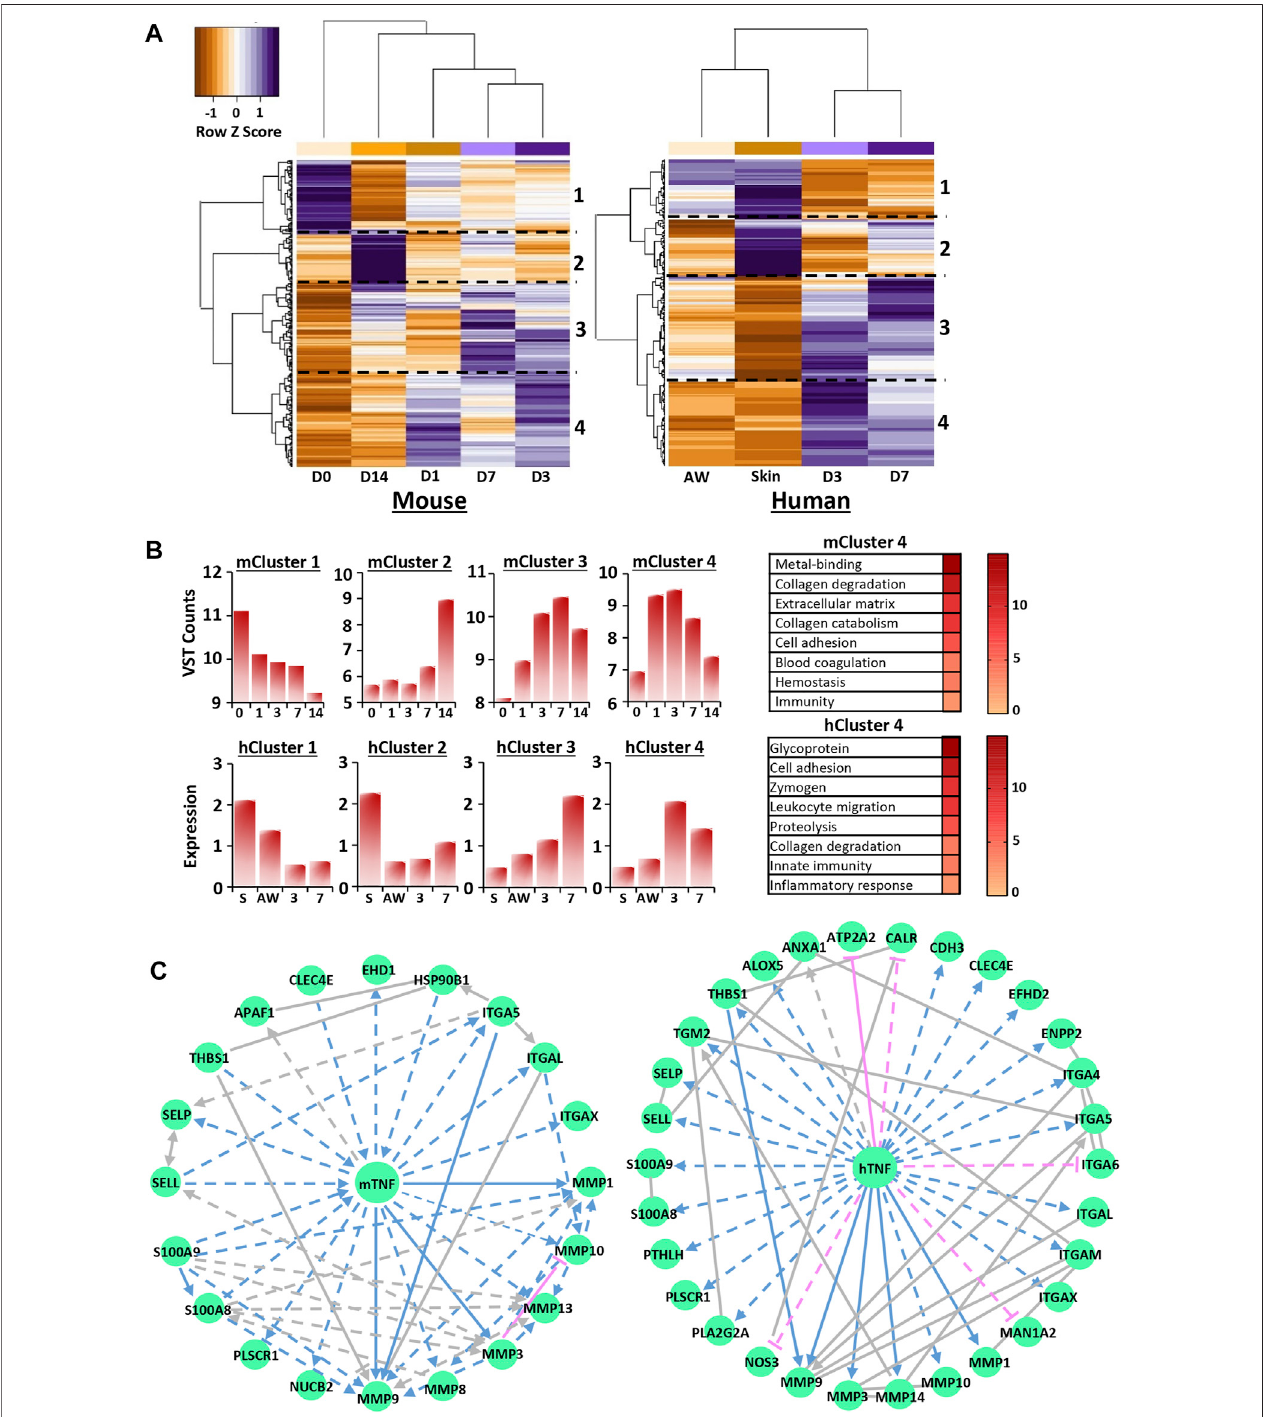
FIGURE 5 | Transcriptional regulation of calcium is wound stage speci fi c and converges on key upstream regulators. Hierarchal clustering of the top 250 most signi fi cantgenesinmouseRNA-Seqandhumanmicroarray fi lteredfromthecalciumUniProtknowledgebase(KB)listforeachspecies[KW-0106; (A) ].D0 (cid:2) normalskin. D1 (cid:2) day 1post-wounding.Cut-off (cid:2) Benjamini-Hochbergadjusted p value( P adjust) < 0.05andlog 2 foldchange (cid:2) 0.58. Functionalannotationofidenti fi edclustersand theirexpressionpro fi les (B) .VST (cid:2) variancestabilisedtransformation.NetworkanalysisidentifyingTNFasatoptranscriptionalregulatorforcluster4 (C) .m,mouse; h, human.